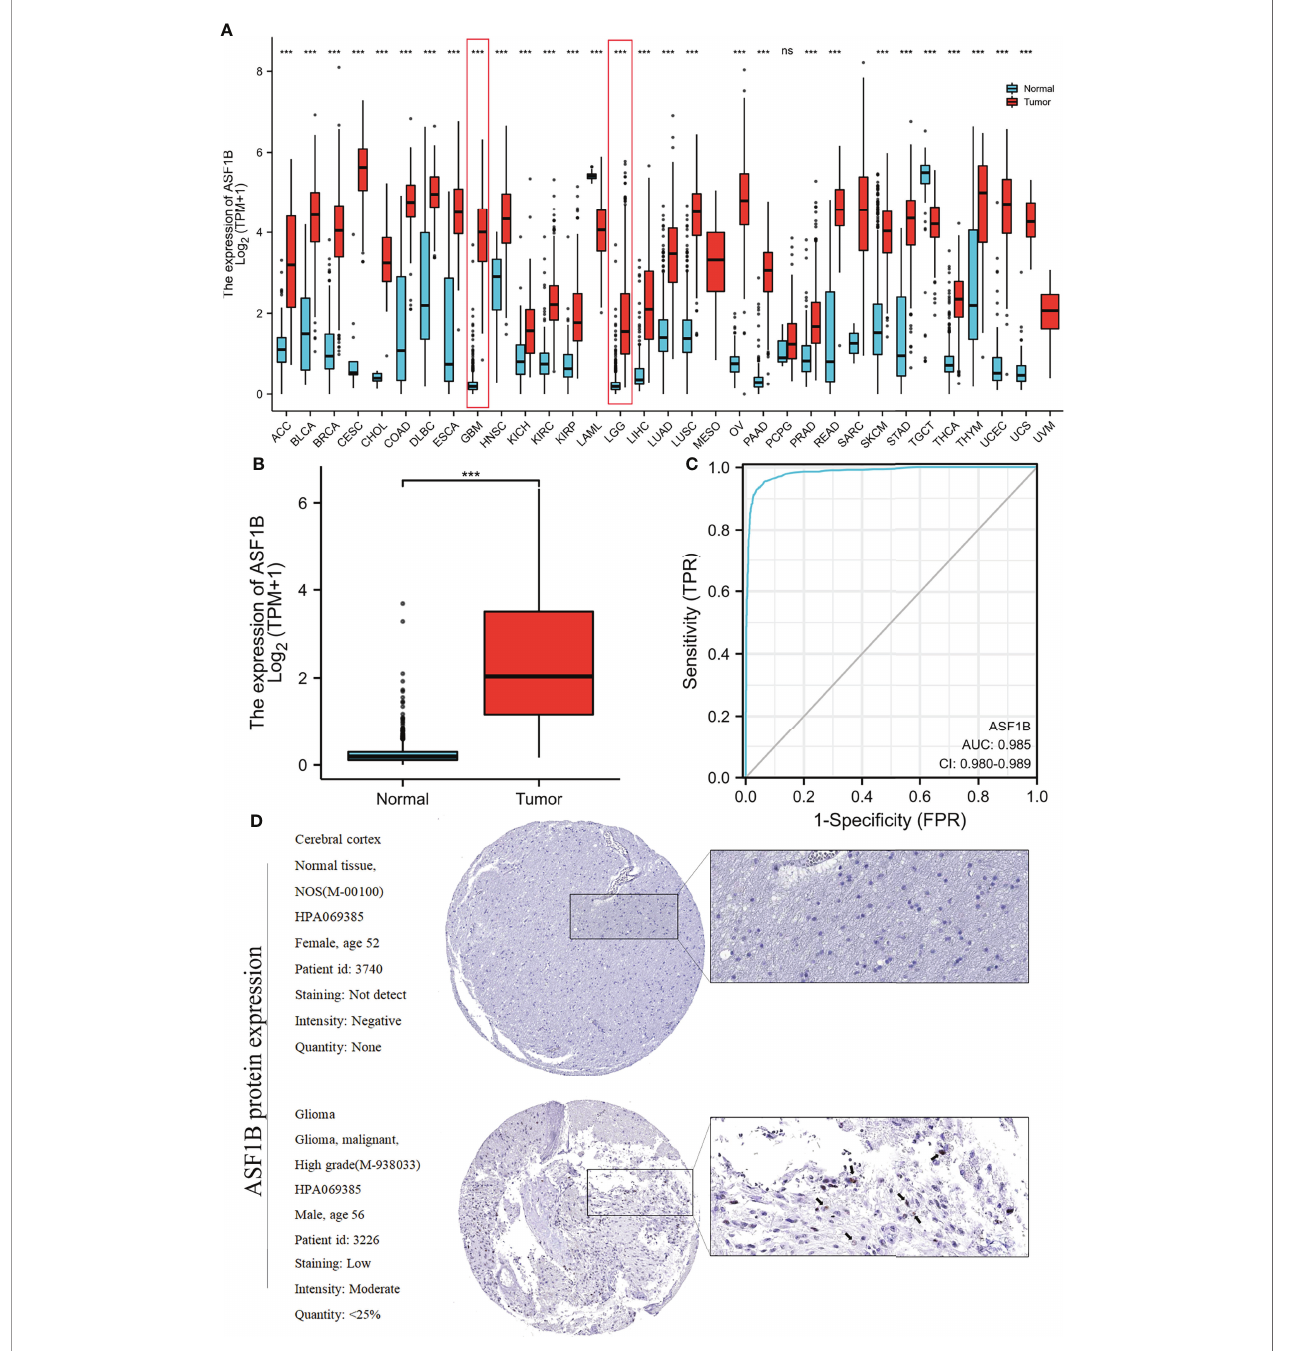
FIGURE 2 | Relationship between ASF1B expression and gliomas. (A) ASF1B expression levels in different tumor types from the TCGA and GTEx databases. (B) ASF1B mRNA expression was signi fi cantly upregulated in glioma tissues compared to normal tissues. (C) Diagnostic value of ASF1B expression in gliomas. (D) ASF1B protein expression in glioma tissues determined using HPA. *** p < 0.001, ns, no statistical